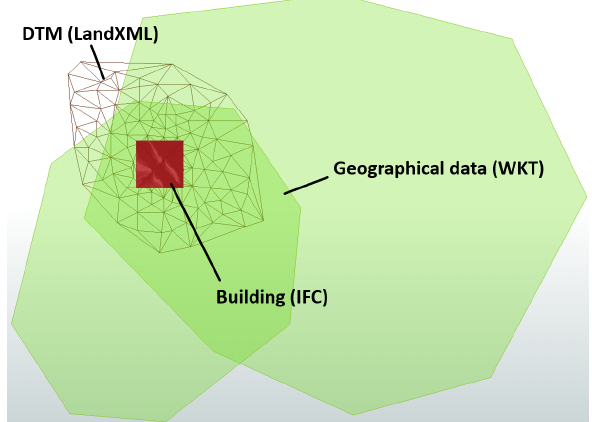
Figure 5. 2D view of test BIM and GIS data from heterogeneous sources.